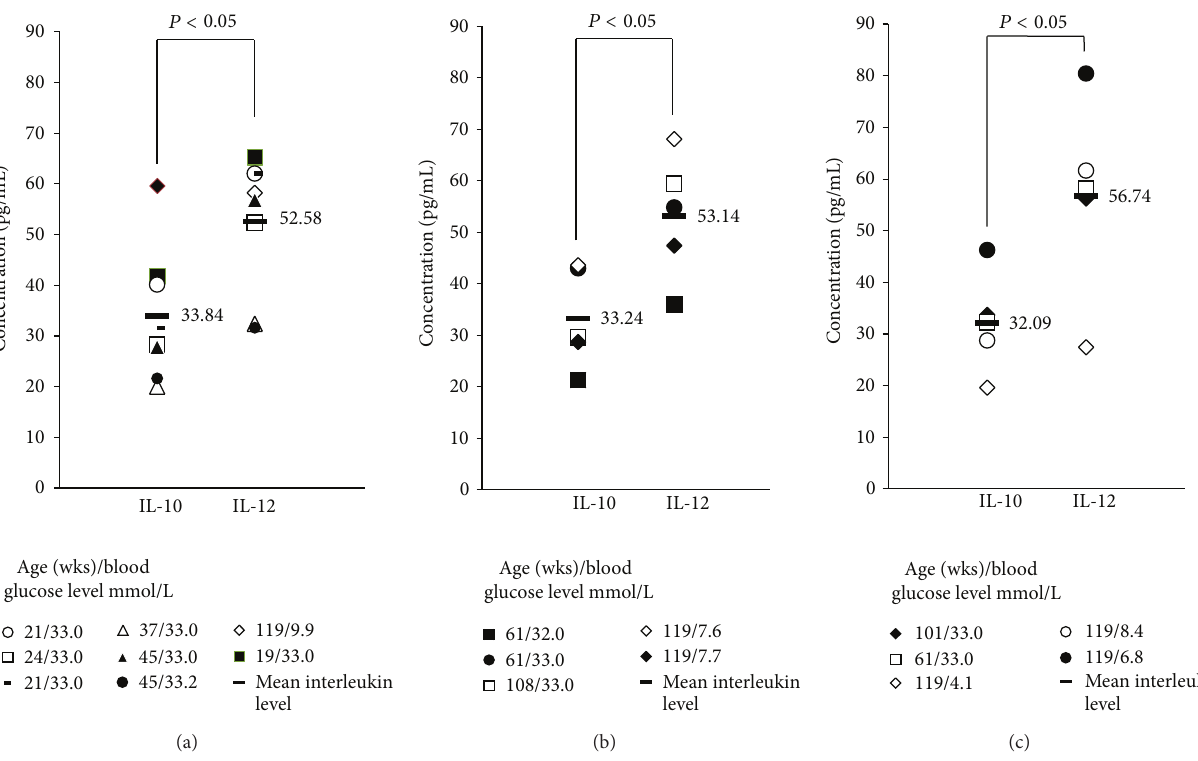
Figure 6: Detection of IL-10 and IL-12 in NOD mouse serum. (a) Secreted cytokines IL-10 and IL-12 in serum samples of the naive, (b) rVV-CTB::GAD + CFA (1:0), and (c) rVV-CTB::GAD + CFA (1:10) groups. Ages and blood glucose levels of individual mice are shown in columns on the right side.